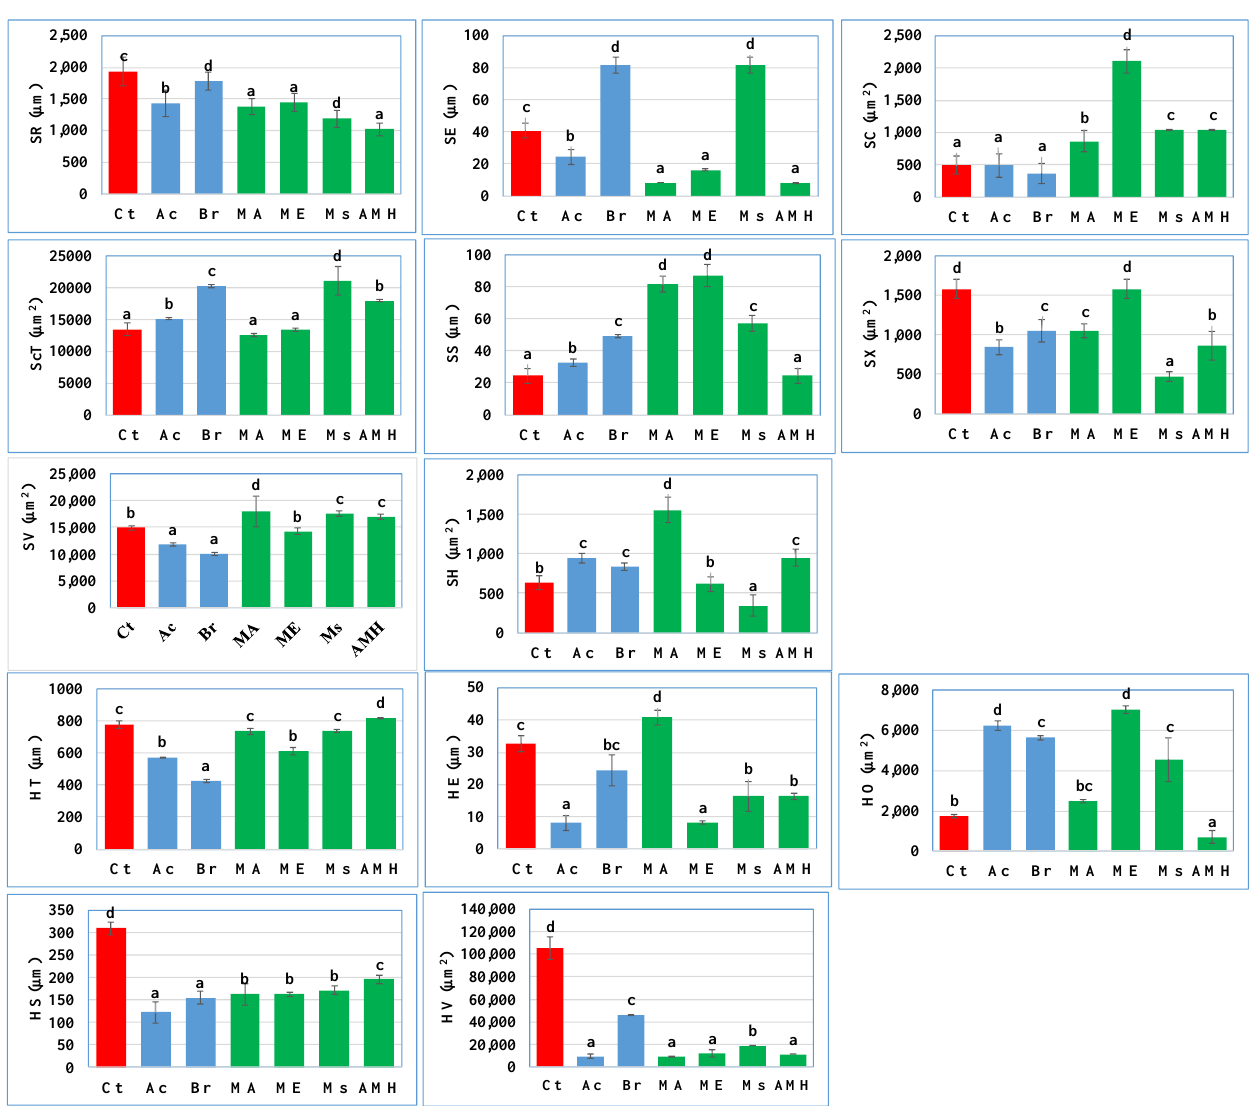
Figure 3. Stem and leaf sheath anatomical characteristics of Dactyloctenium aegyptium treated with pre- and post-emergence herbicides. Means sharing same lowercase letters on bars are statistically non−significant at p ≤ 0.05%) Red bar indicates control group, blue bars show pre-emergence and green bars are used for post-emergence herbicides. For abbreviations please see list at the end of manuscript.